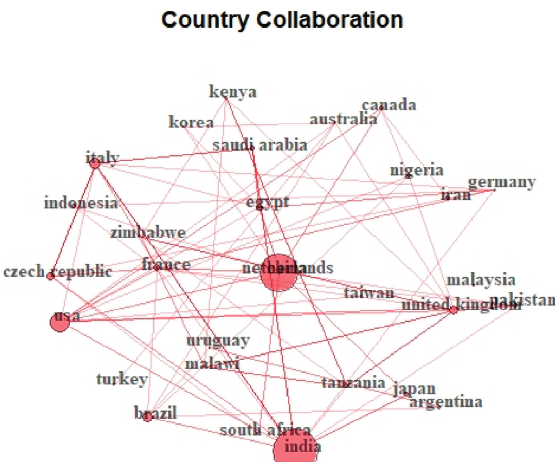
Figure 4: Country collaboration network of the top 30 most productive countries on green pesticide research. Line thickness represents the collaboration strength between Table 4: The top 30 most cited documents on green pesticide research from 1994 to 2019 from Scopus. Rank